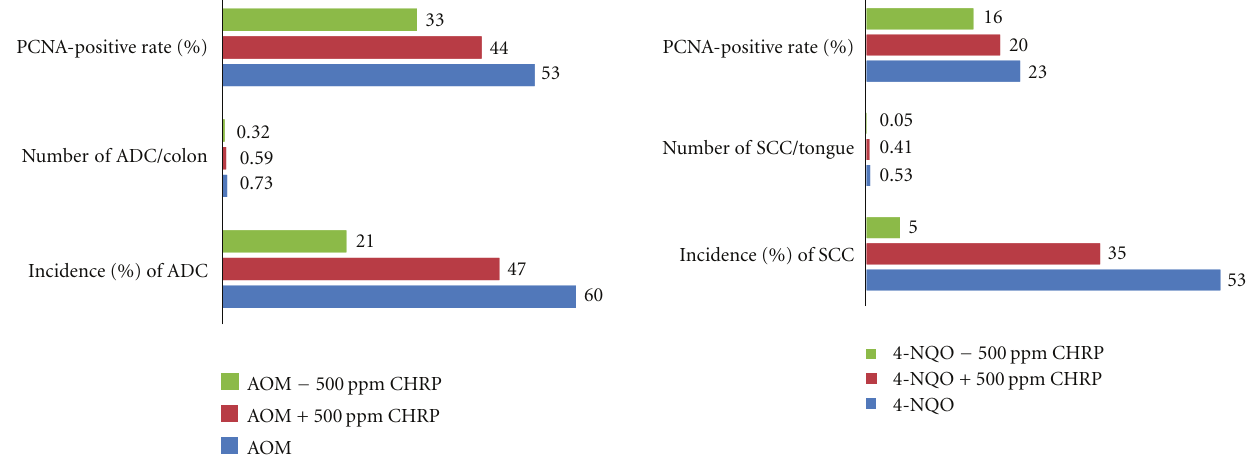
Figure 3: Dietary CHRP inhibits AOM-induced colonic adenocar- cinoma (ADC) in rats.